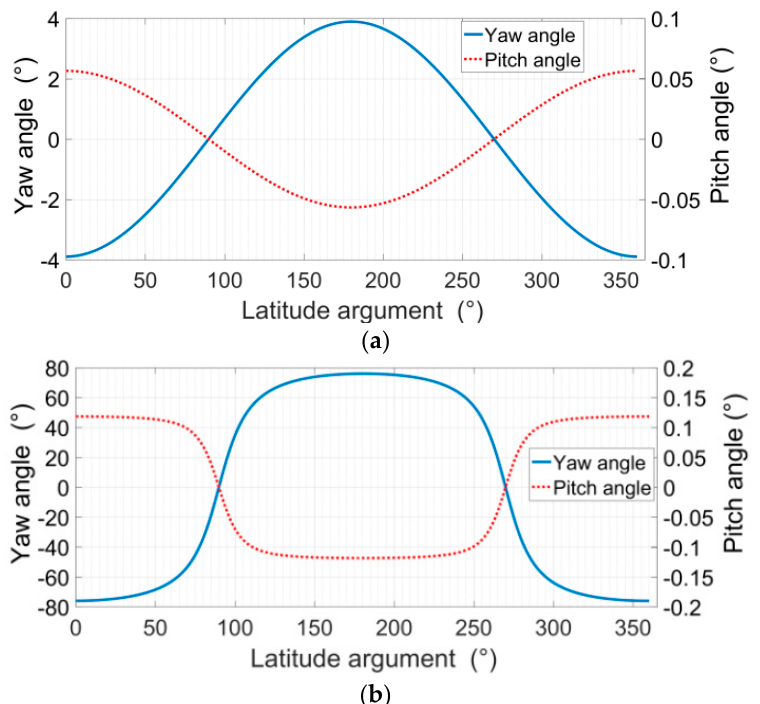
Figure 2. Yaw angle, and pitch angle of GF-3 and Geo-SAR in one orbital period. ( a ) GF-3 satellite. Its